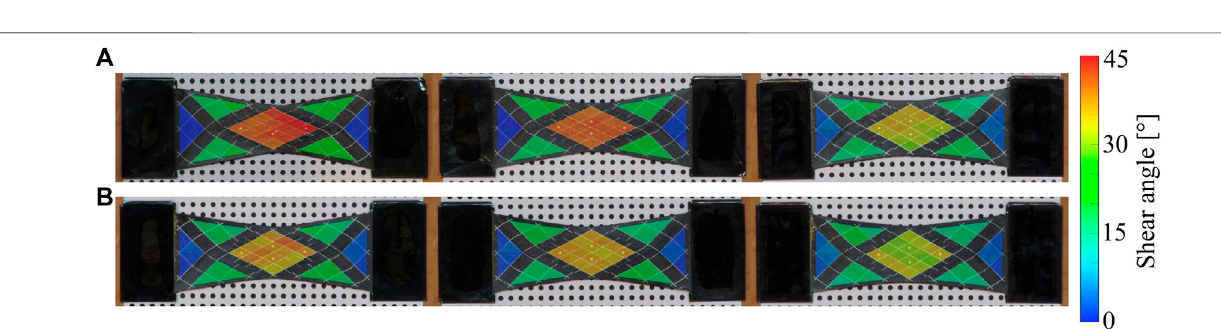
FIGURE 6 | Shear angle distribution after the test, overview of all specimens. Note: Colors are half transparent overlay on specimen pictures leading to a darker appearance.